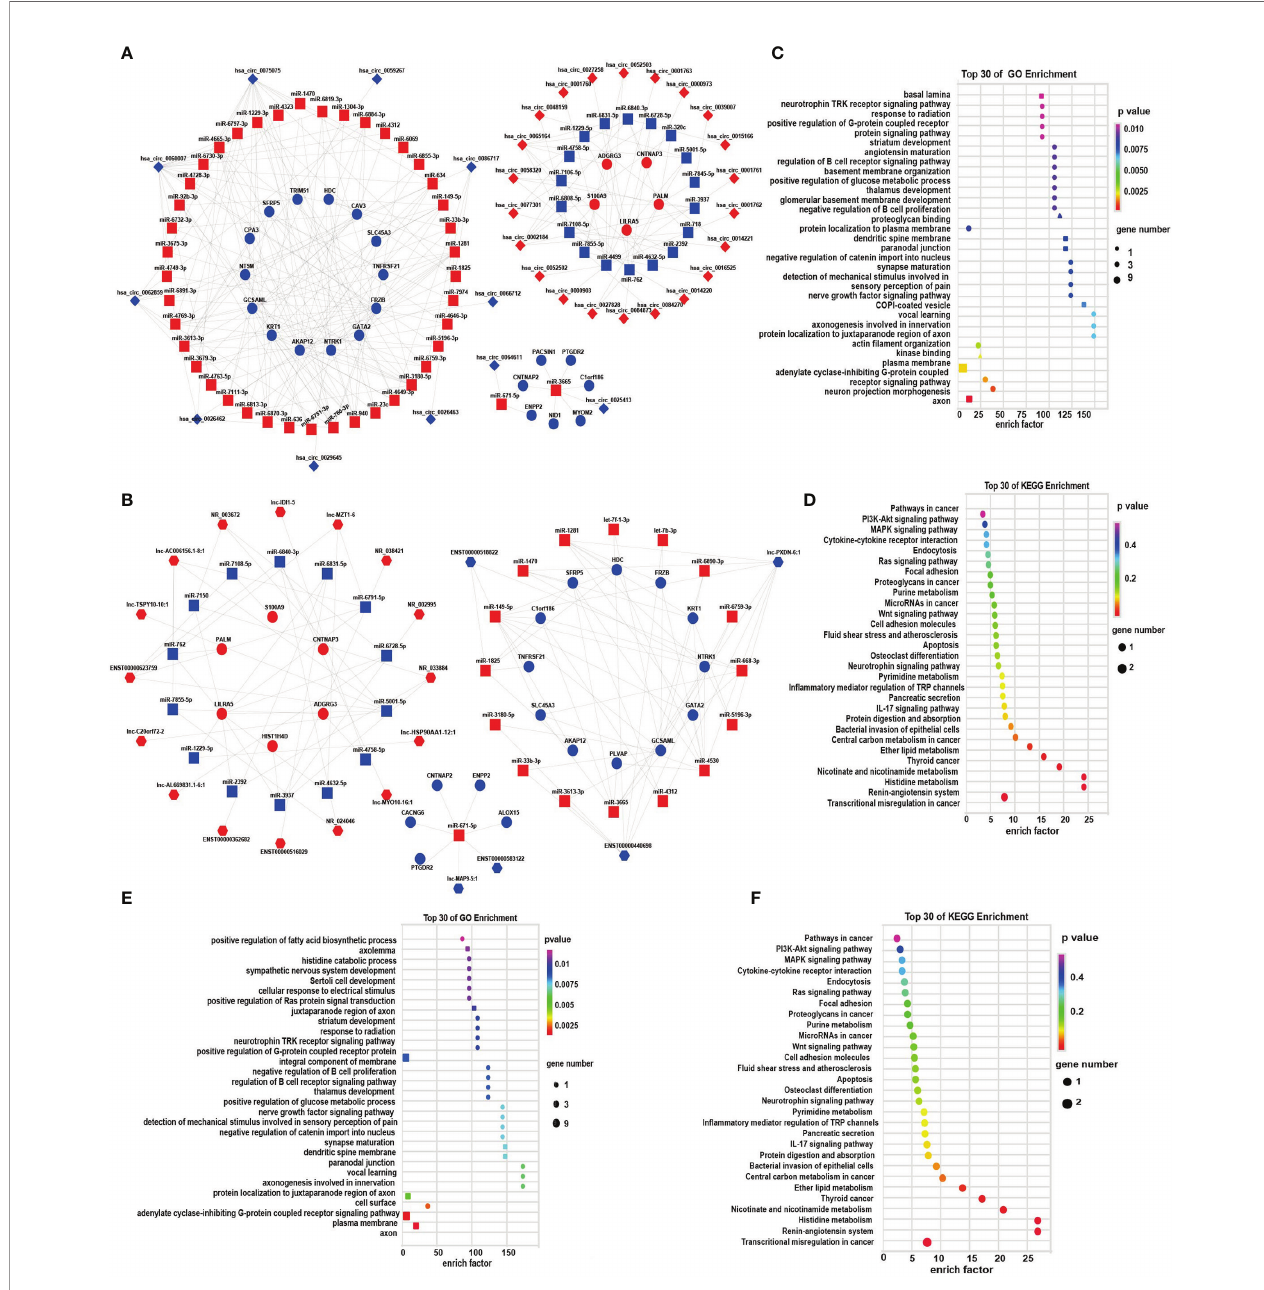
FIGURE 5 | The circRNA/lncRNA-associated ceRNA networks, GO, and KEGG enrichment. (A) ceRNA network of circRNA-miRNA-mRNA; (B) ceRNA network of lncRNA-miRNA-mRNA, diamond-, hexagon-, square-, and circle-shaped nodes represent circRNA, lncRNA, miRNA, and mRNA, respectively. Red and blue represent upregulation and downregulation, respectively. (C, D) GO and KEGG enrichment of circRNA associated ceRNA networks, respectively; (E, F) GO and KEGG enrichment of lncRNA-associated ceRNA networks, respectively. (BP: ■ ; CC: ▲ ; MF: ● in GO